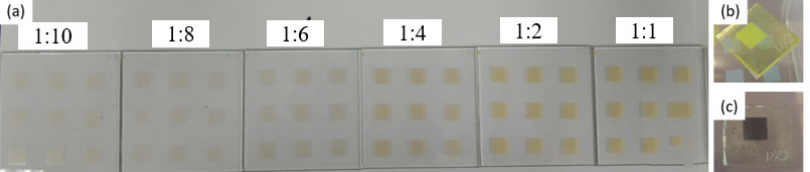
Figure 2. The top-view pictures of ( a ) the TiO 2 thin film prepared from different ratios of Pb:Ti; ( b ) the PbI 2 /TiO 2 thin film prepared by dipping the PbO-TiO 2 nanoparticle electrode into HI solution; ( c ) the perovskite/TiO 2 thin film prepared by dipping the PbI 2 /TiO 2 thin film into CH 3 NH 3 I solution.